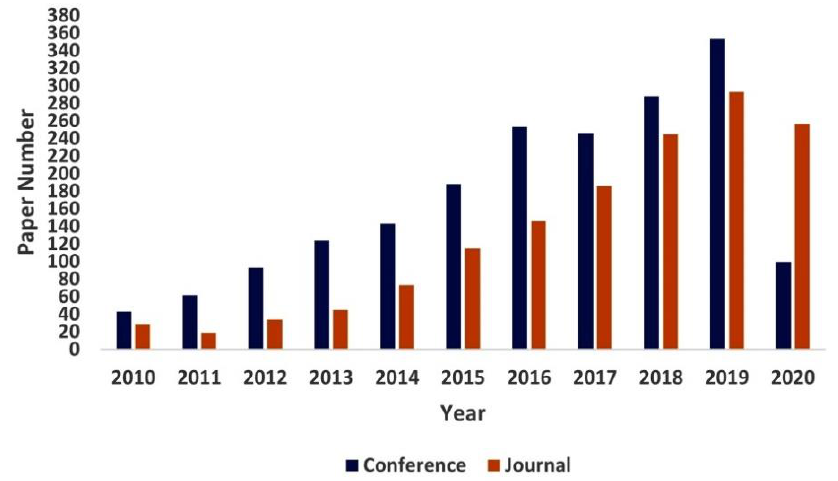
Figure 2. Papers referring to RF energy harvesting from 2010 until 2020.